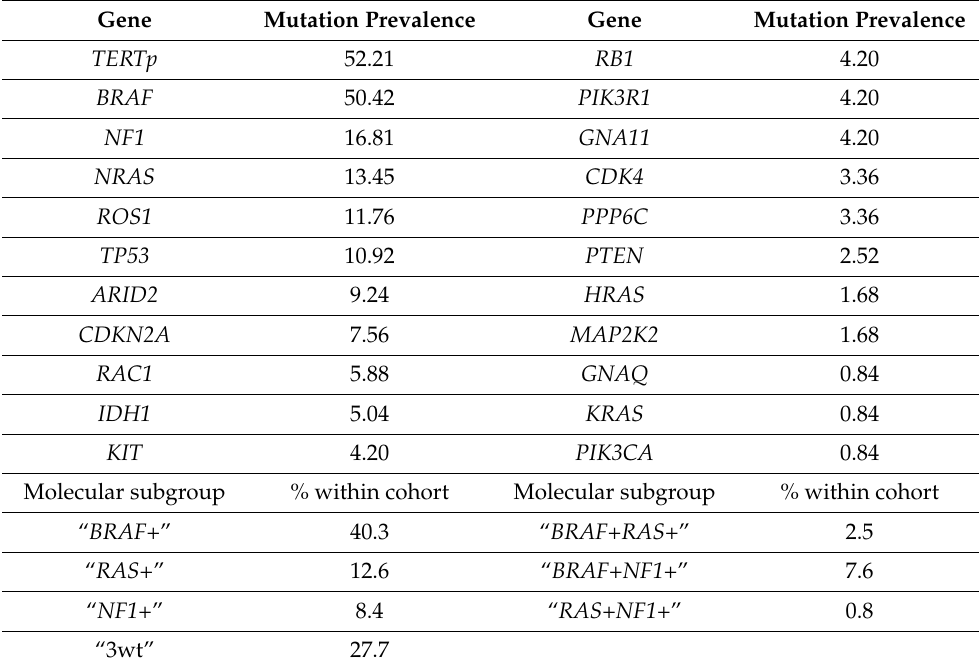
Table 2. Mutational prevalence in our cohort and classification into molecular subtypes. Gene Mutation Prevalence Gene Mutation Prevalence